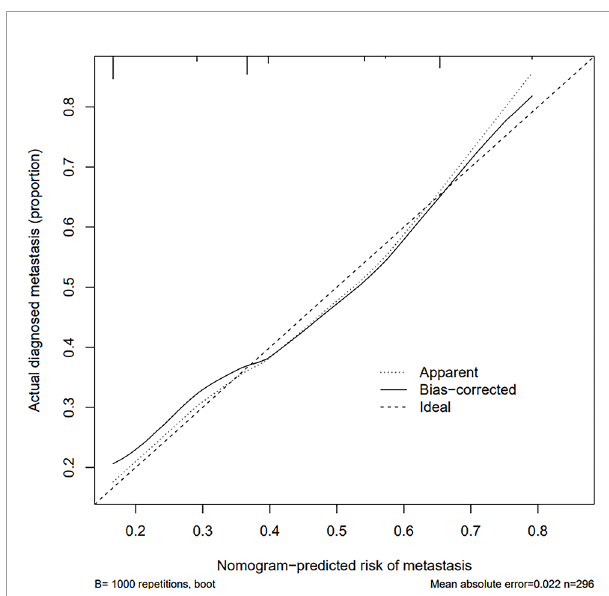
FIGURE 5 | Calibration curves of the prediction nomogram. The solid line is close to the diagonal dotted line, which represents a good prediction ability. The x-axis represents the predicted central CLNM. The y-axis represents the actual central CLNM. The diagonal dotted line represents the perfect prediction by the ideal model. The solid line represents the performance of the nomogram, where a closer fi t to the diagonal dotted line means a better prediction.